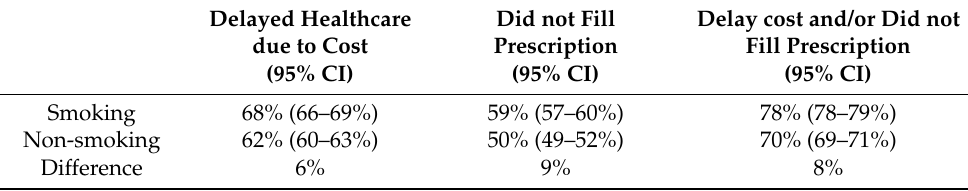
Table 3. Simulated healthcare utilization and compliance between smokers and